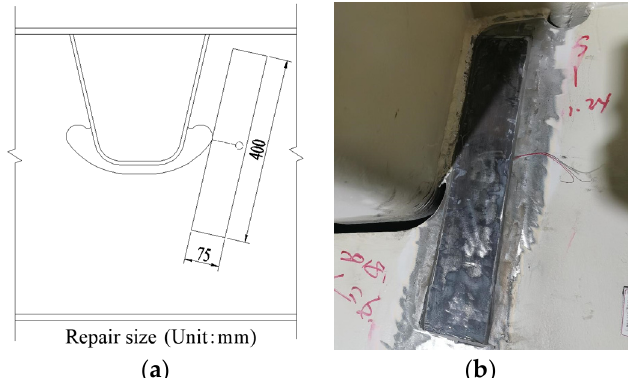
Figure 14. Schematic of the repair scheme for the diaphragm: ( a ) geometric dimensions, ( b ) reinforcement presentation.